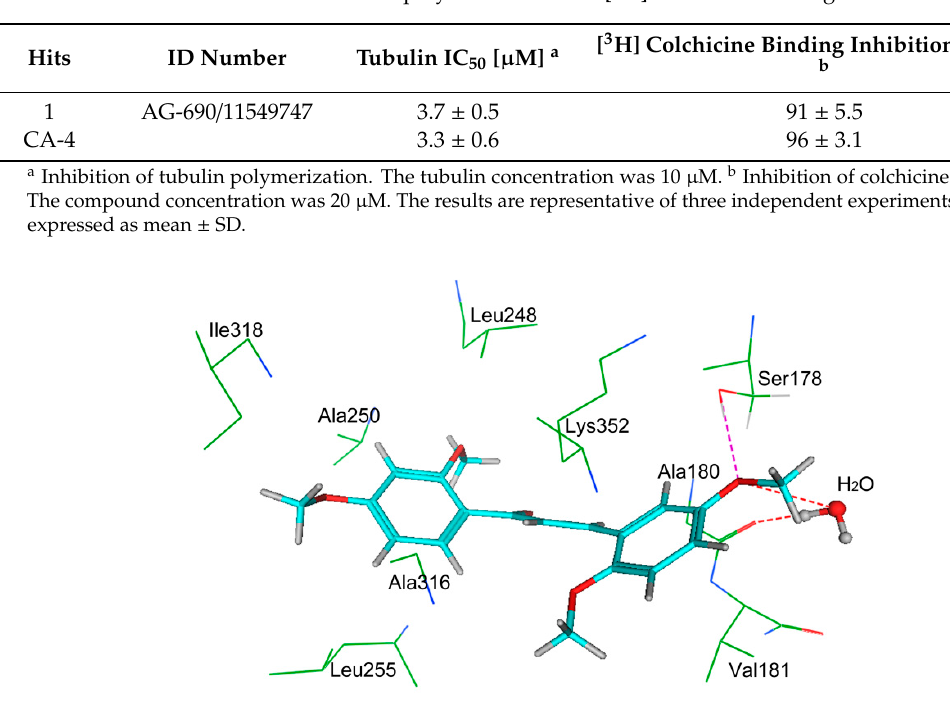
Figure 5. The three-dimensional (3D) ligand–protein interaction diagram for the binding site of tubulin (PDB ID: 6F7C) with hit 1. The active site residues and water molecules are shown in stick form. The hydrogen-bond network with protein residues is represented as red dotted lines. Hit 1 is color-coded as